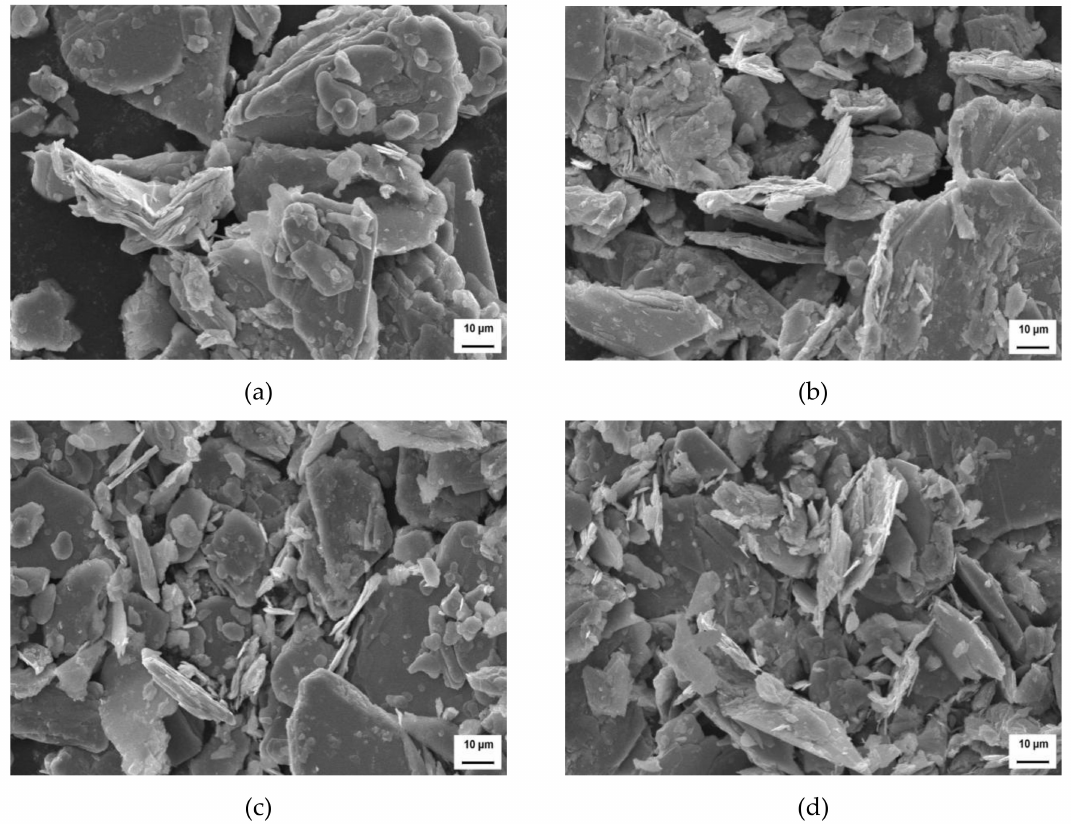
Figure 5. SEM images of molybdenite ( a ) t = 0 min; ( b ) t = 3 min; ( c ) t = 6 min; ( d ) t = 9